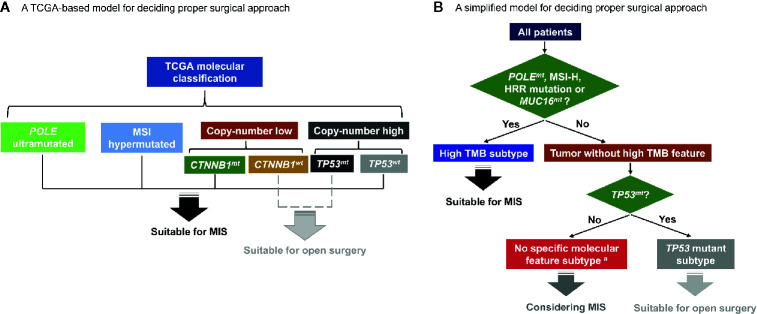
Hypothetical schemas for choosing surgical approaches based on patients’ molecular features. (A) A TCGA-based model for deciding proper surgical approach. (B) A simplified model for deciding proper surgical approach. TCGA, the Cancer Genome Atlas; MSI, microsatellite-instability; CTNNB1mt, CTNNB1 mutation; CTNNB1wt, CTNNB1 wild type; TP53mt, TP53 mutation; TP53wt, TP53 wild type; MIS, minimally invasive surgery; POLEmt, POLE mutation; MSI-H, microsatellite-instability high; HRR, homologous recombination repair; MUC16mt, MUC16 mutation; TMB, tumor mutation burden. a Patients with concurrent TP53mt and CTNNB1mt are excluded and should be separately discussed.